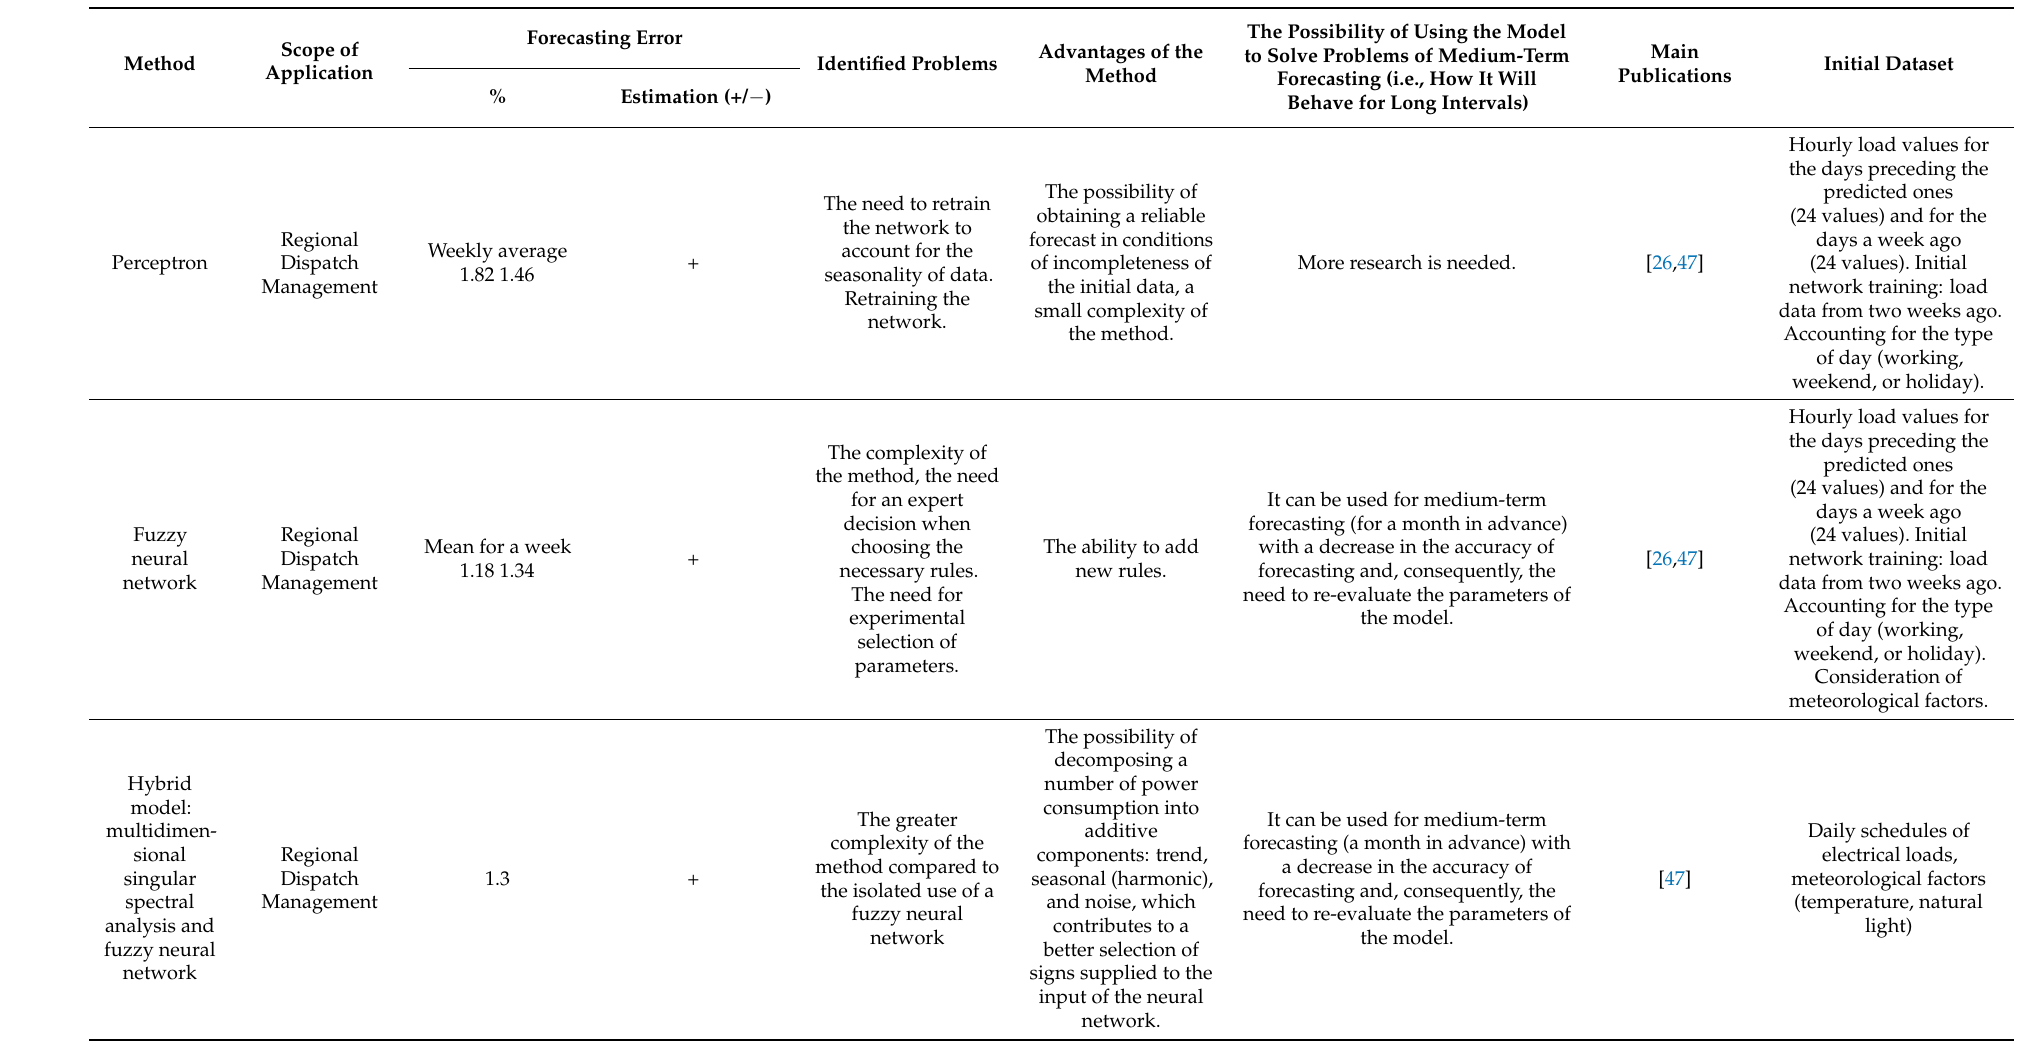
Table 2. Analysis of methods used in short-term forecasting of electricity